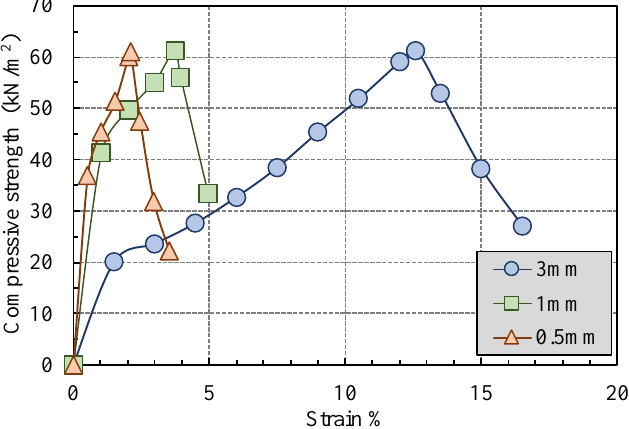
Figure 7. Comparison of simulation results for different soil sizes.